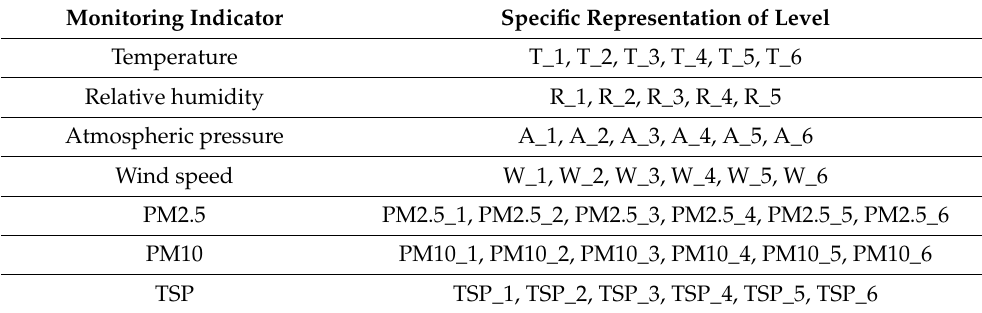
Table 10. Discrete level representation of monitoring indicator.